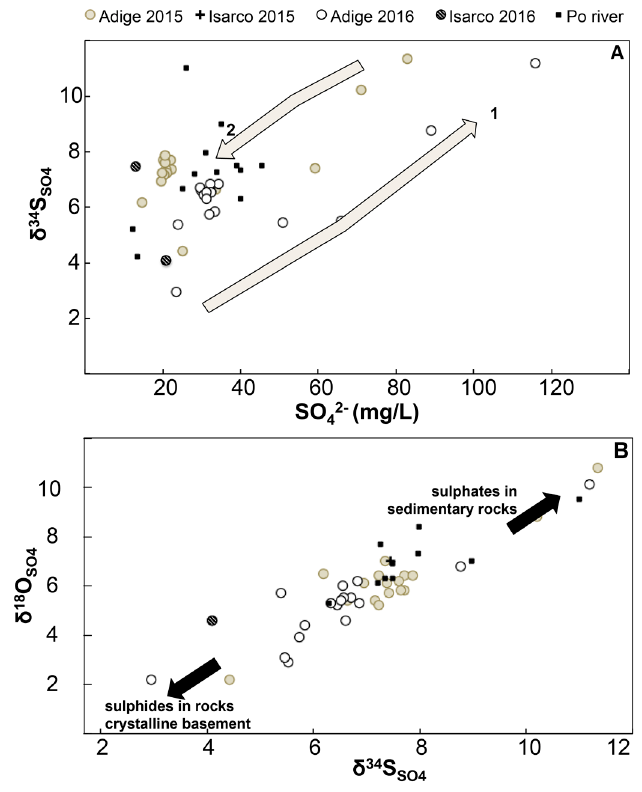
Figure 5. ( A ) SO 42 − vs. δ 34 S SO4 diagram reporting the sulphate concentration and the relative δ 34 S of Adige river water and the Isarco tributary. Arrow 1 represents the evolution observed in the first 11 km of the Adige course; arrow 2 represents the evolution toward a more mature river water composition observed in most of the river course. The Po river water samples are also represented; ( B ) δ 34 S SO4 vs. δ 18 O SO4 in Adige river water. The arrows indicate possible geogenic sources.